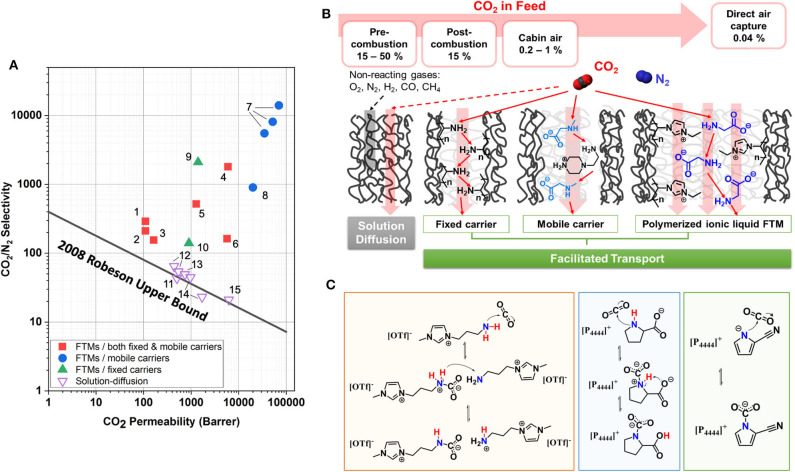
(A) FTMs with ILs in comparison to solution–diffusion membranes on Robeson plot for CO2/N2 separation. References for data: (1) (Chen and Ho, 2016), (2) (Chen et al., 2016), (3) (Han et al., 2018), (4) (Zou and Ho, 2006), (5) (El-Azzami and Grulke, 2009), (6) (Han et al., 2018), (7) (Moghadam et al., 2017a), (8) (Moghadam et al., 2017b), (9) (Kamio et al., 2020), (10) (McDanel et al., 2015), (11) (Teodoro et al., 2018), (12) (Tomé et al., 2018), (13) (Tomé et al., 2014), (14) (Scovazzo, 2009), (15) (Jindaratsamee et al., 2012). The selectivity and permeability data of FTMs shown in this figure are available in Table 1. (B) Schematics of CO2 transport in solution–diffusion membranes (feed with >15% CO2) and FTMs (feed with <15% CO2). Specific examples of polyvinylamine studied by Tong and Ho (2017) and amino acid salt by Chen and Ho (2016) illustrate the fixed carrier and mobile carrier FTMs, respectively. As an example to FTM with a polymerized IL, polymerized imidazolium with glycinate counter ion studied by Kamio et al. (2020) is also shown. (C) Reaction schemes for CO2-reactive ILs. Left: n-(3-aminopropyl)-n-methyl-imidazolium triflate. A zwitterion (CO2  −-NH2  +_) forms by the formation of the CN bond in the first step, followed by the transfer of proton from the zwitterion complex to another amine, thus forming ammonium and carbamate ions. Middle: tetrabutyl phosphonium prolinate, [P4444][Pro]. Zwitterion formation in the first step is followed by an intramolecular hydrogen transfer that results in carbocylic acid. Right: tetrabutyl phosphonium 2-cyanopyrrolide, [P4444][2-CNpyr]. Nucleophilic addition of CO2 to AHA nitrogen forming carbamate with no hydrogen transfer involved.